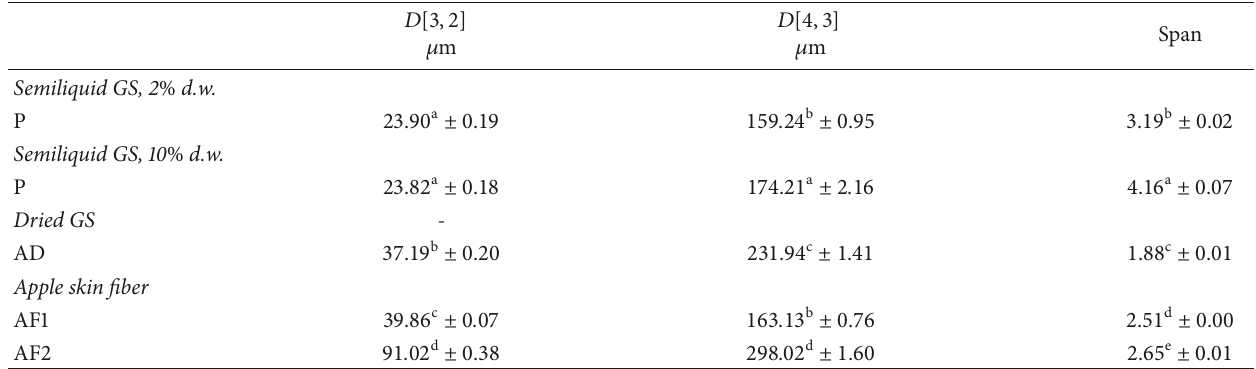
Table 4: Particle size distribution for the proposed dried and semiliquid food ingredients recovered from GS and for commercial apple skin fibers ∗ .